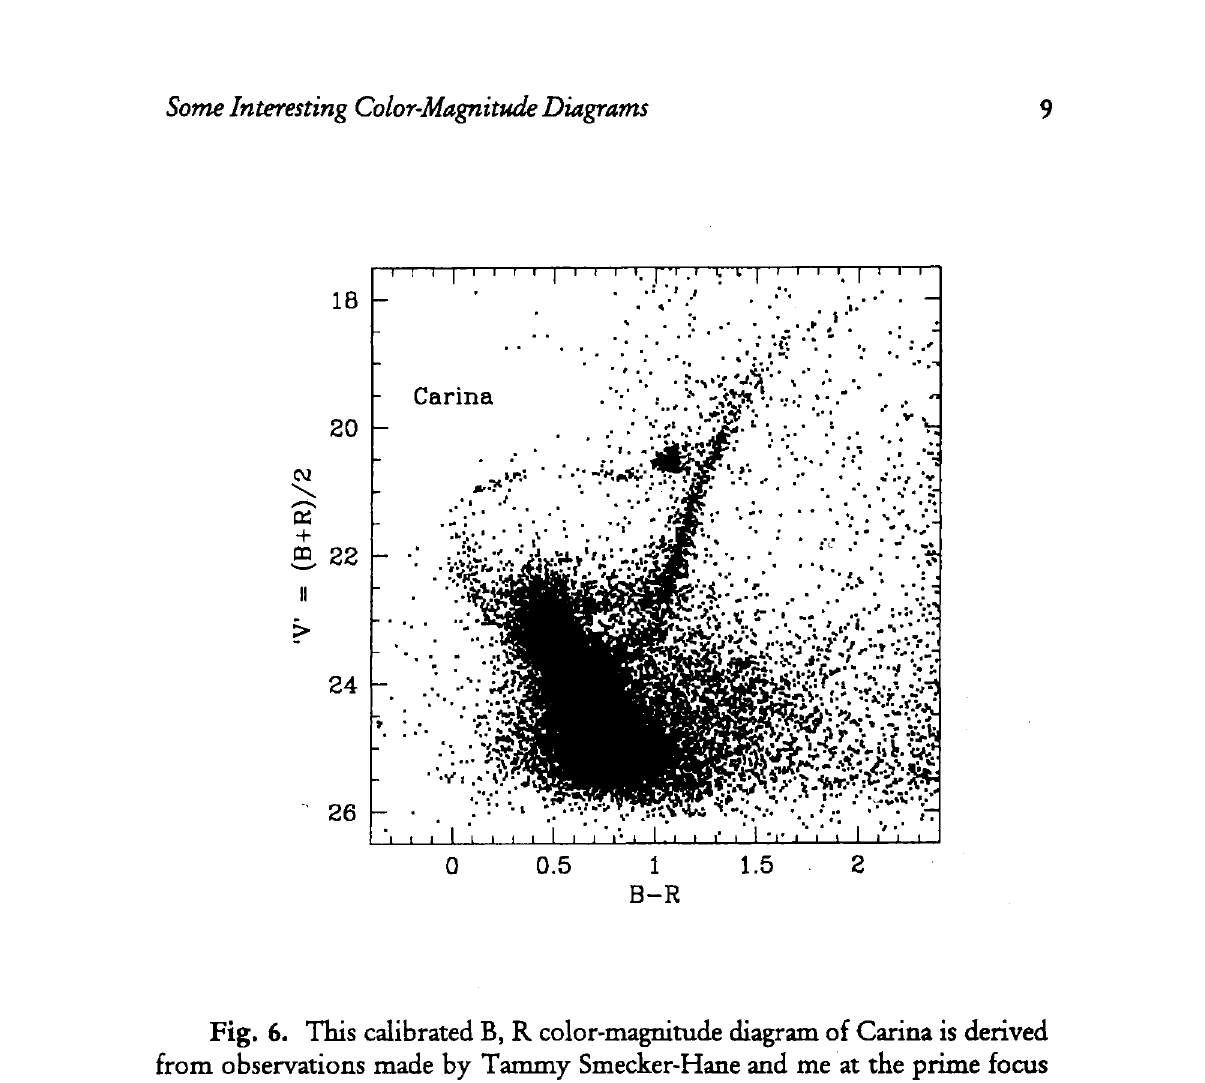
Fig. 6. This calibrated B, R color-magnitude diagram of Carina is derived from observations made by Tammy Smecker-Hane and me at the prime focus of the CTIO 4 m telescope. This diagram shows clear evidence of a significant burst of star formation some 13 - 15 Gyr ago, followed by a much stronger burst some 6 -7 Gyr ago, and perhaps some trailing off of the star formation rate after that time. There is a clear gap between the two subgiant branches, suggesting only minor star formation, if any, between 13 and 7 billion years ago. A strong clump of core helium-burning stars belonging to the younger generation(s) is seen above the red end of the horizontal